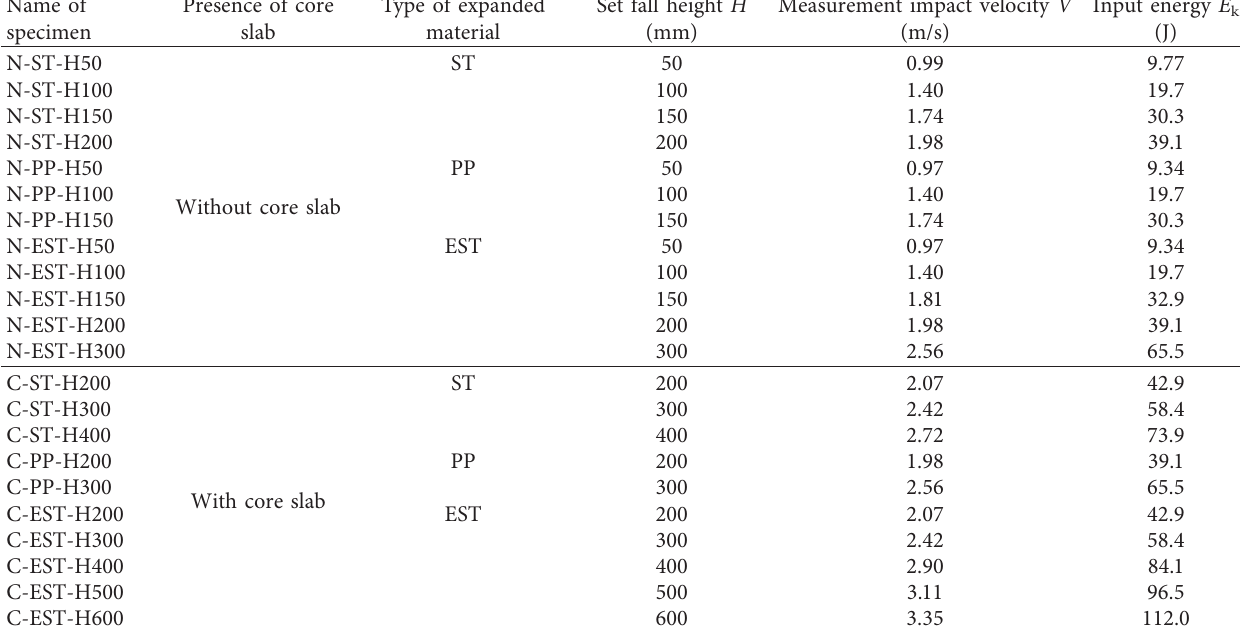
Table 2: Specimen